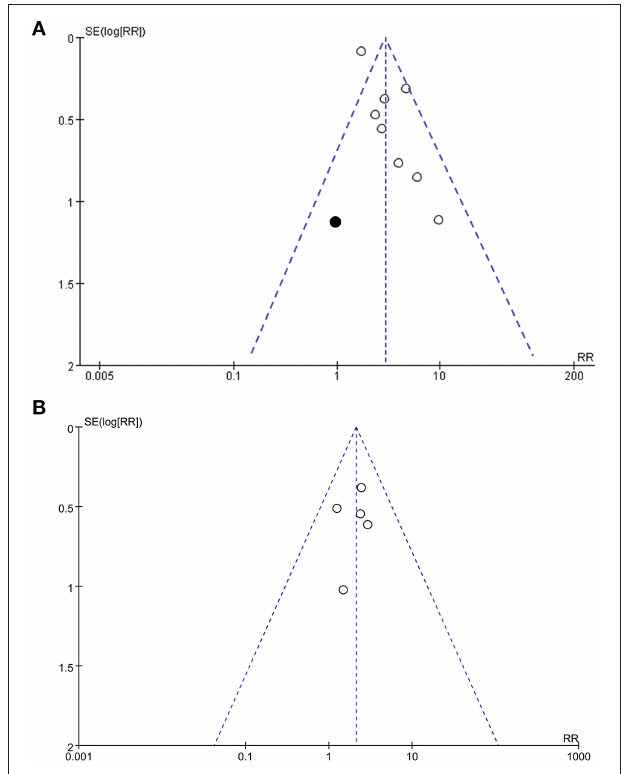
FIGURE 4 | Funnel plots for the meta-analyses; (A) , Funnel plots with trim-and-fill analysis for the meta-analysis concerning the association between frailty and risk of all-cause mortality after PCI (black square indicates the hypothesize study to achieve the symmetry of the funnel plots); and (B) , Funnel plots for the meta-analysis concerning the association between frailty and risk of MACEs after